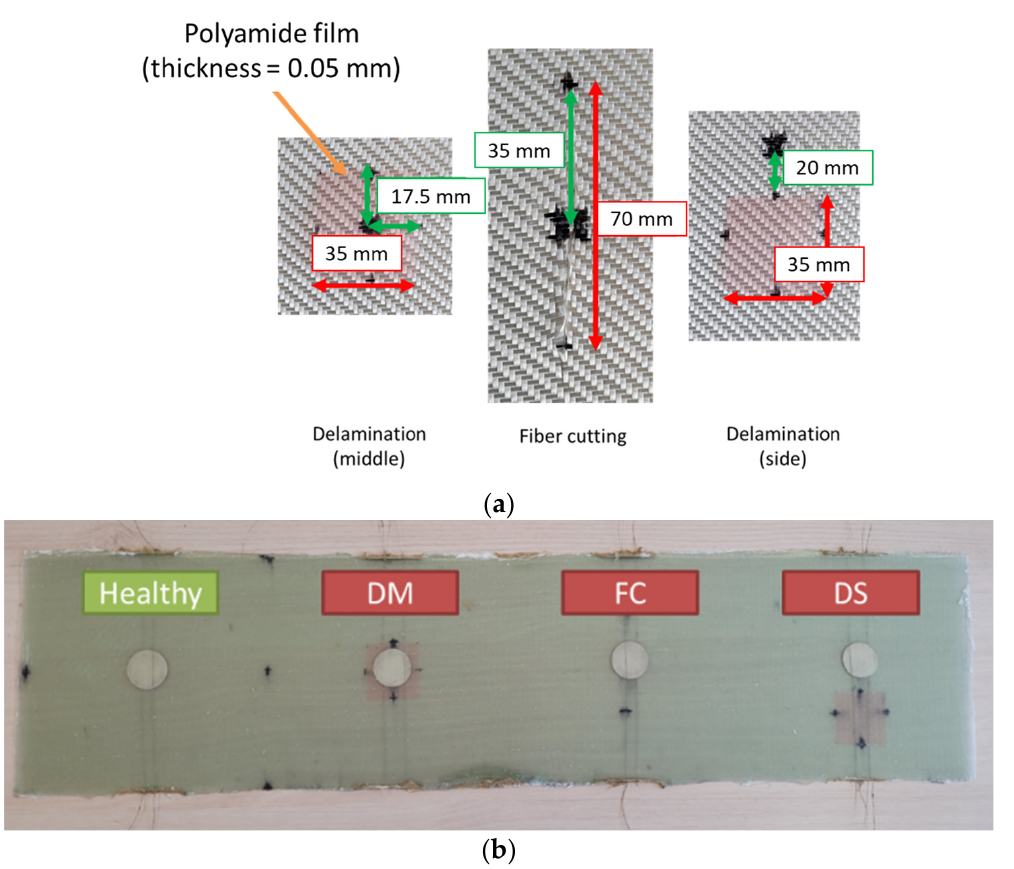
Figure 2. (a) Damage insertion and (b) manufactured plate before cutting. Figure 2. ( a ) Damage insertion and ( b ) manufactured plate before